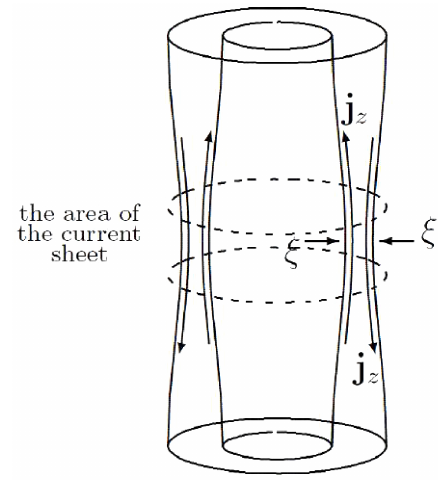
Figure 5. A formation of current sheets at the apex of the coronal loop by its principal sausage mode: j z marks longitudinal electric currents, and ξ marks the plasma